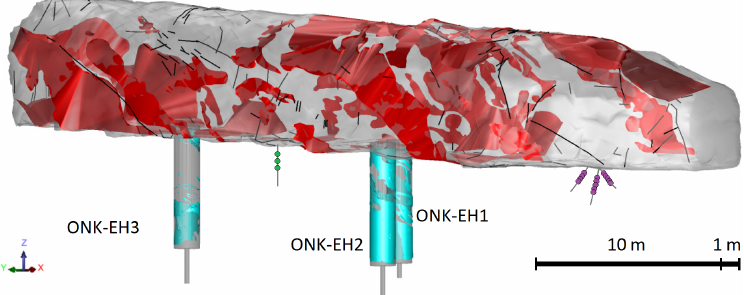
Figure 1. Lithology of the POSE niche along with the location of ONK-EH1, ONK-EH2, and ONK-EH3 experimental holes. Red colour indicates PGR rock around the POSE niche. Turquoise colour depicts the VGN intrusions around the experimental holes. Fractures mapped around the niche are shown by black lines. Green dots and purple dots indicate the location where pegmatitic granite rock and veined gneiss samples were taken respectively (after Valli et al.,